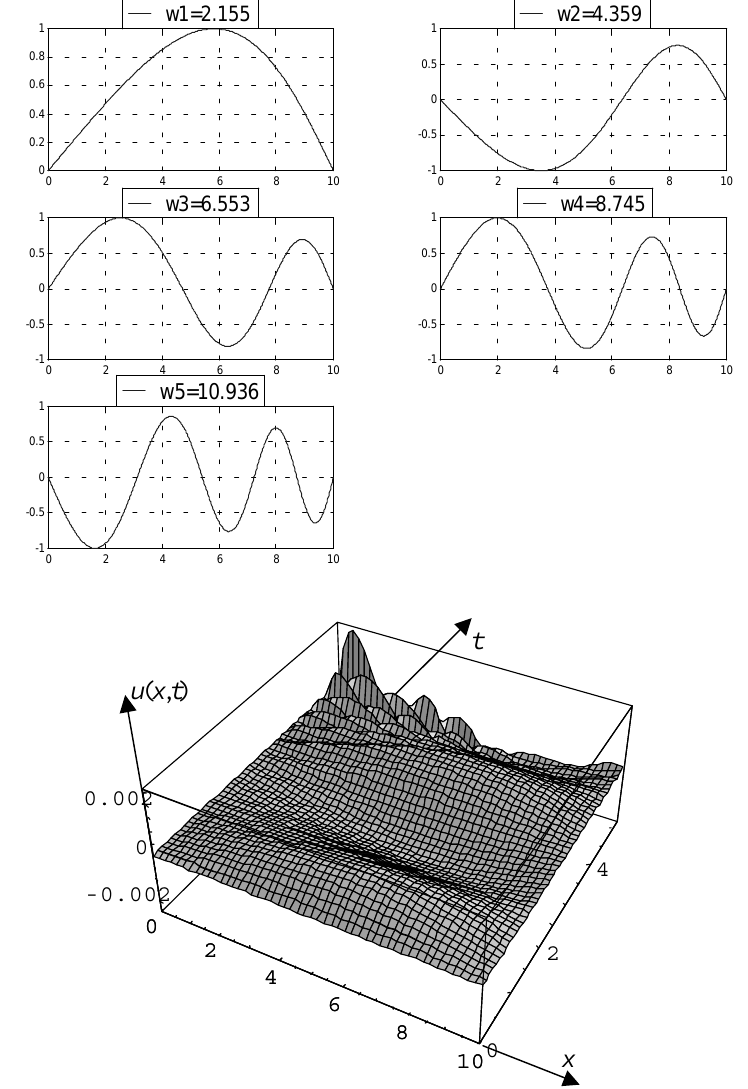
Fig. 7. First five eigenfunctions and time response of an aluminum fixed-fixed rod with an exponentially increasing